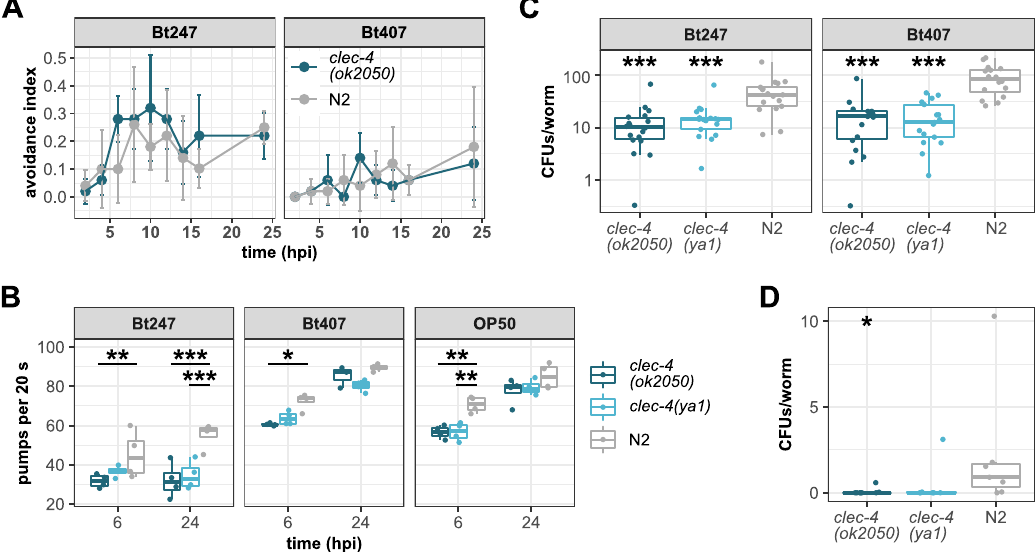
Fig 3. clec-4(ok2050) and clec-4(ya1) decrease C . elegans feeding leading to a reduced bacterial load. (A) Avoidance behavior of clec-4(ok2050) and N2 wildtype worms on Bt247. Worms were exposed to a mild concentration (1:400) of non-pathogenic Bt407 and pathogenic Bt247. The avoidance index is defined as (initial total number of worms–worms on bacterial spot) / initial total number of worms. Means ± SD of n = 5, no significant differences between clec-4(ok2050) and N2 were determined by a generalized linear mixed model (GLMM) [59] per bacterial treatment, p -values corrected for multiple comparisons with Bonferroni [60]. (B) Pumping rate of clec-4(ok2050) , clec-4(ya1) , and N2 wildtype worms on a 1:100 dilution of Bt247 and Bt407, n = 4, data are representative of three independent experiments. � p < 0.05, �� p < 0.01, ��� p < 0.001, according to GLMM per bacterial treatment and per worm strain, Bonferroni corrected [60]. (C, D) Bacterial load on (C) a Bt dilution of 1:100 or (D) OP50 measured in colony forming units (CFUs) per worm. Shown are pooled data, (C) n = 18 or (D) n = 16 combined from three independent experiments. � p < 0.05, ��� p < 0.001, as determined by Wilcoxon rank sum test, Bonferroni corrected [60]. Also see S2B and S3D–S3F